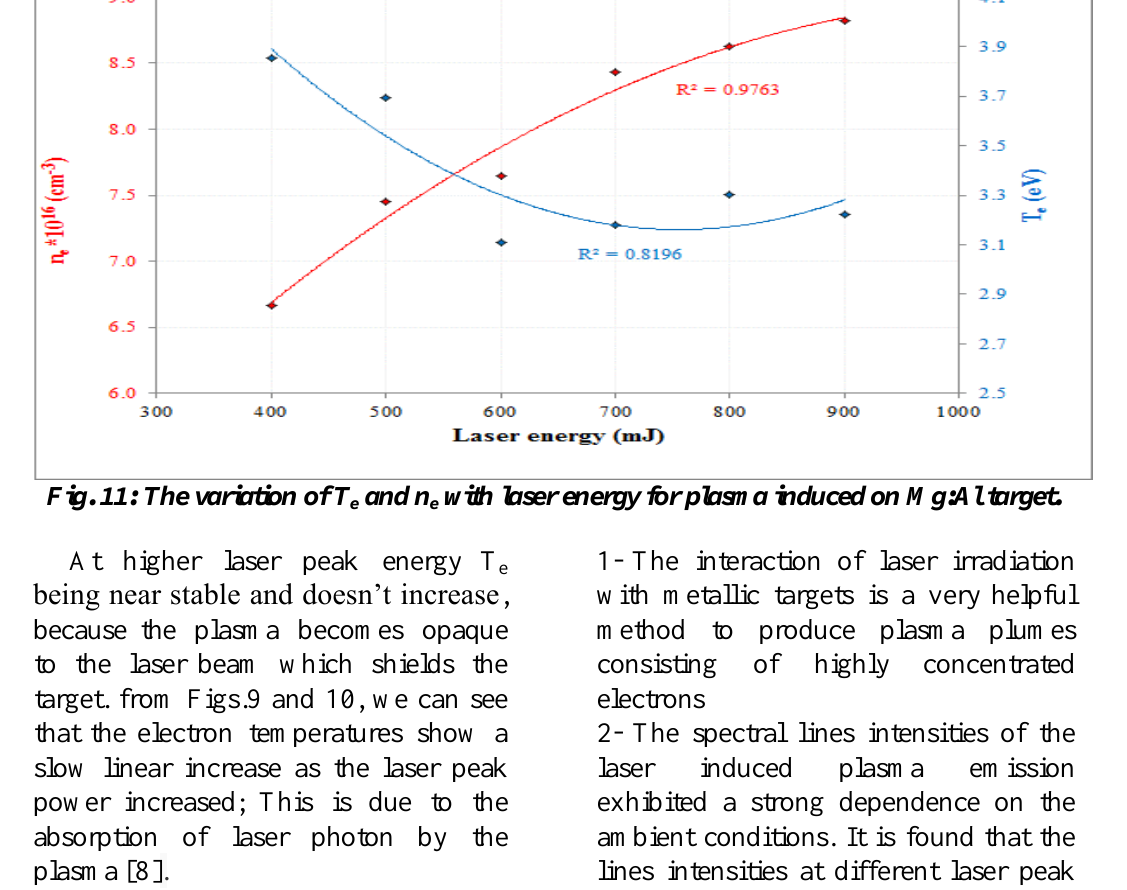
and n with laser energy for plasma induced on Mg target. e e